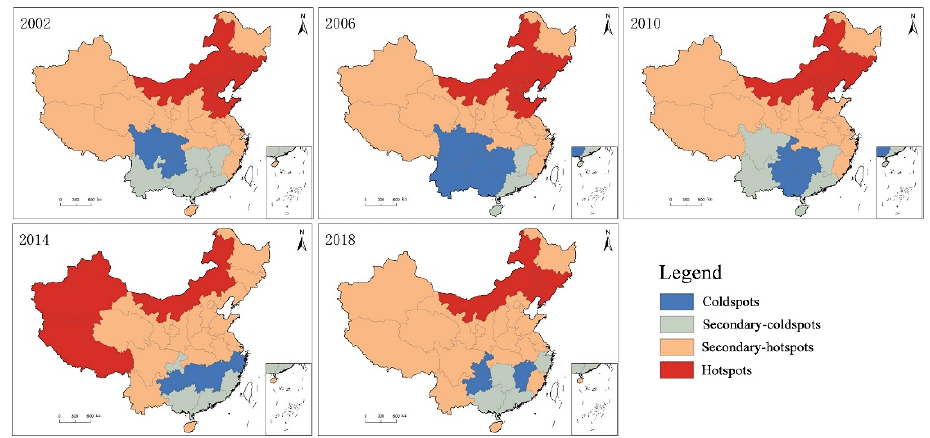
Figure4. Figure 4. The spatial evolution of hotspots versus coldspots with regard to Chinese citizens’ health index.